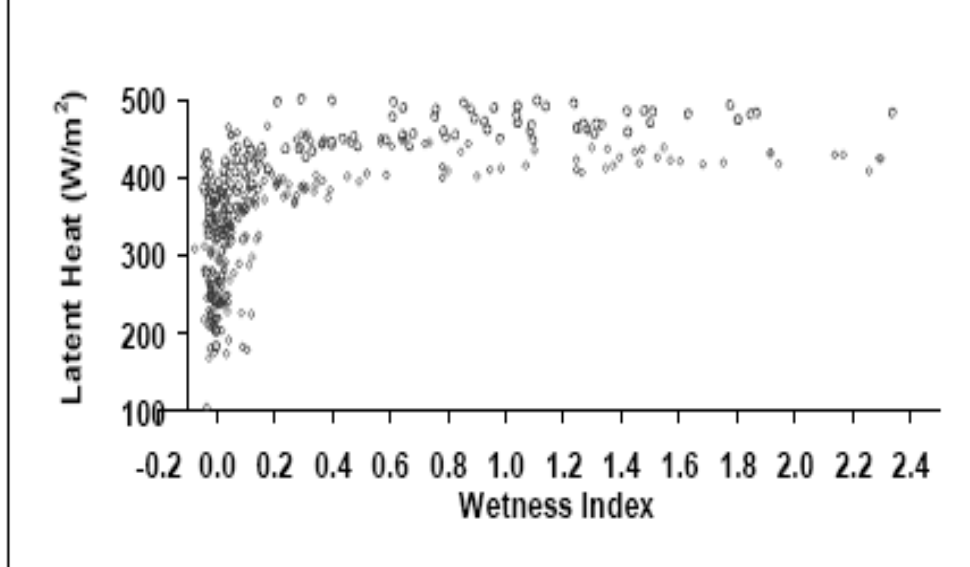
Figure 9. Wetness index vs. latent heat flux for a wheat